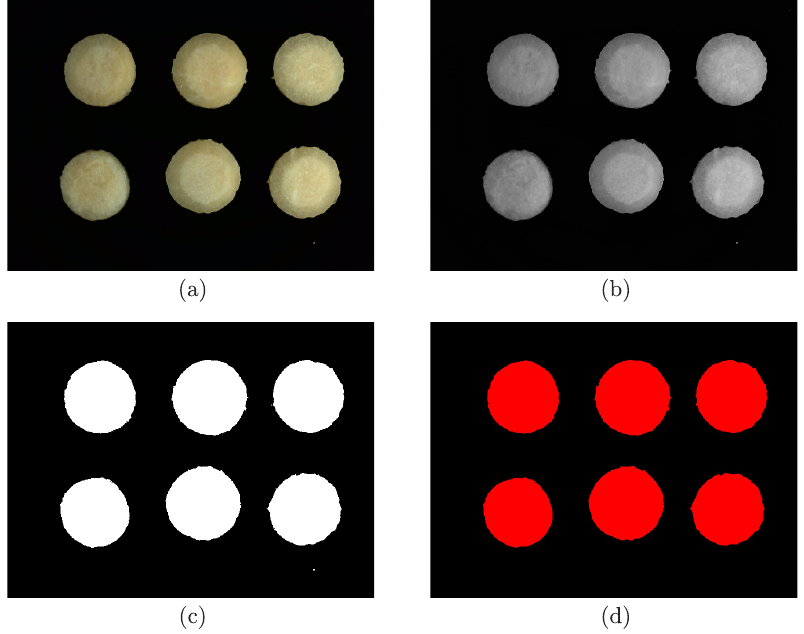
Figure 2. The image processing steps: ( a ) original RGB image before processing; ( b ) grayscale image; ( c ) binary image; ( d ) image after the operation of filling holes and filtering